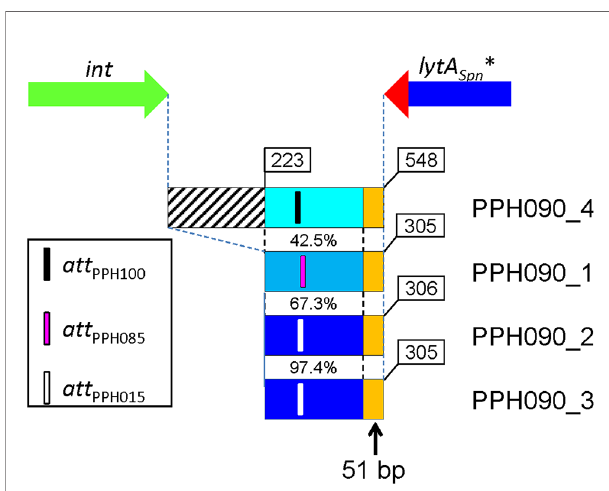
FIGURE 3 | Organization of the DNA region located between the 3 ’ ends of the int and lytA Spn * genes. Genes are not drawn to scale. Four prophages of the PPH090 family were examined. The intergenic region is longer in PPH090_4 (belonging to the serine Int family) than in the other PPHs with tyrosine Ints. The percentage nucleotide identities are indicated. The approximate positions of the attP core sequences are shown. Two of the prophages belong to the PPH015 group and the corresponding whole regions are 97.4% identical. Orange rectangles represent the 51 bp-long perfectly conserved sequence located immediately 3 ’ from lytA PPH and lytA Spn